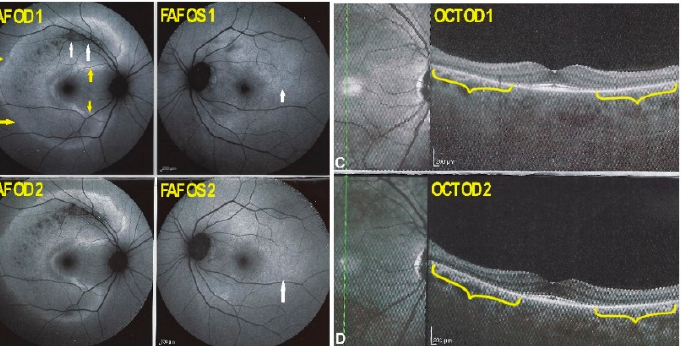
Figure 8. BL-FAF & SD-OCT in AZOOR patient 2 at presentation and follow-up. Blue light FAF ODS at presentation ( A )and after 18 months ( B ) showing OD a reniform (C-shaped, yellow arrows) hyperfluorescence due to loss of outer segments of photoreceptors except in the arcuate area along the superior temporal arcade (white arrows) corresponding to FA hyperfluorescence and ICGA hypofluorescence due to chorioretinal atrophy. The bl-FAF of the left eye shows discreet hyperautofluorescence temporal superior to the fovea (A,B, FAF OS1 and FAF OS2 white arrow). SD-OCT OD shows ± identical loss of the photoreceptor outer segment line at presentation ( C ) and after 18 months ( D ).